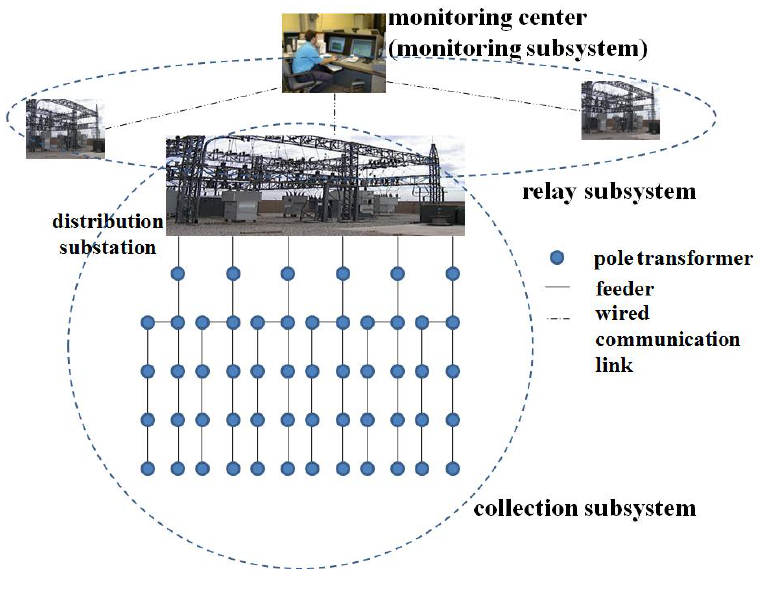
Figure 2. Electrical distribution